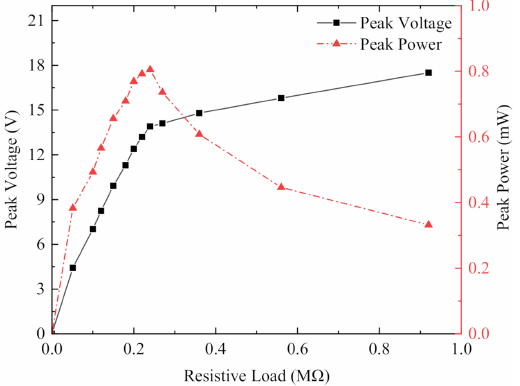
Figure 12. Output voltage and power of non-magnetically coupled piezoelectric capturer x-x piezo- electric